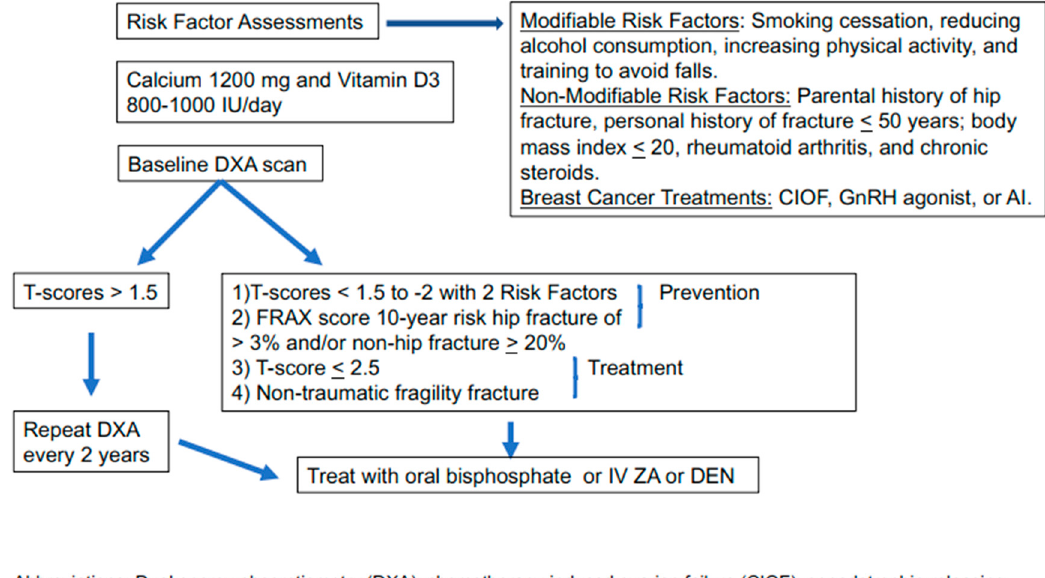
Figure 3. Algorithm for bone heath in women with breast cancer. Assessment of fracture risk starts with dividing the risk factor assessment into modifiable and non-modifiable risks. Every woman should take 800–1000 IU/day vitamin D 3 and calcium 1200 mg/day (made up of dietary sources and supplemental calcium). Vitamin D 3 deficiency (10 ng/mL or less) or insufficiency (11–20 ng/mL) is